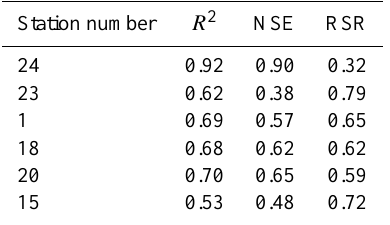
Table 4. Model evaluation measures for runoff for selected stations.